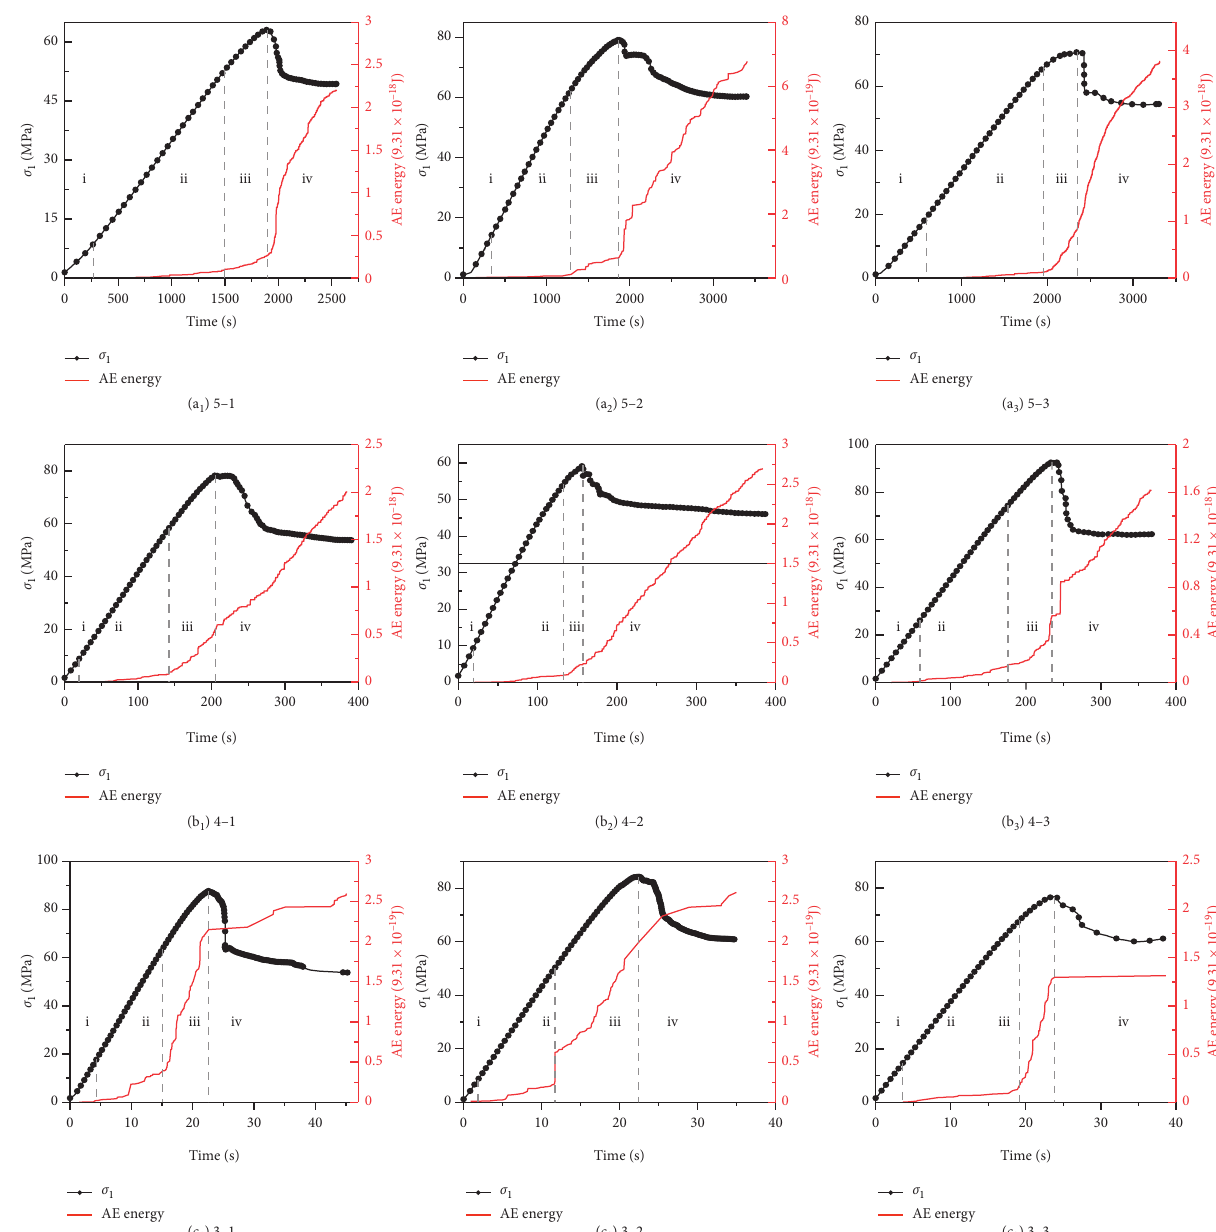
Figure 3: AE energy at different strain rates. (a) _ ε � 10 − 5 s − 1 . (b _ ε � 10 − 4 s − 1 . (c) _ ε � 10 − 3 s − 1